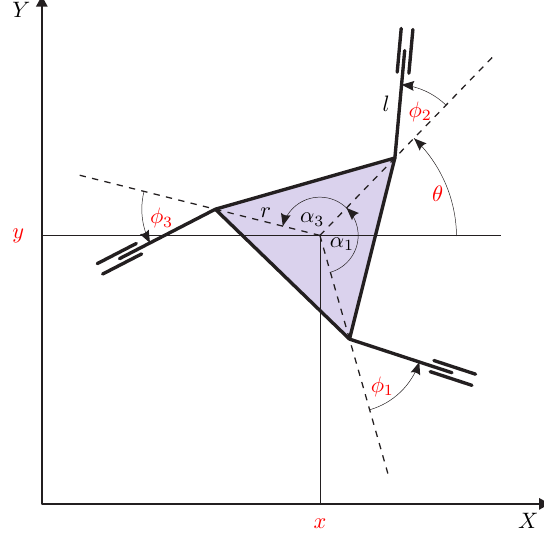
Figure 1. Trident snake robot: conceptual